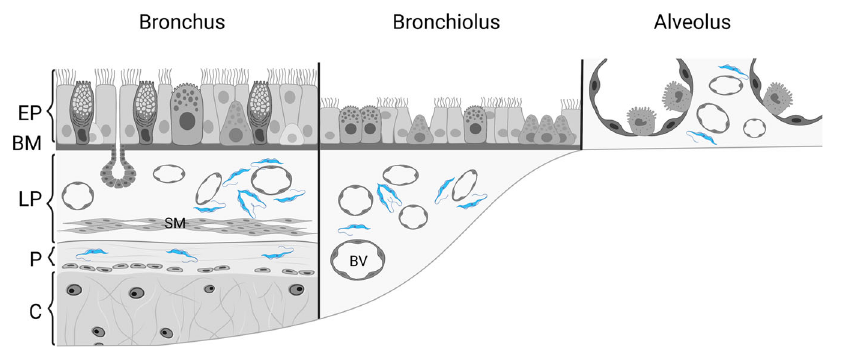
Fig.10|Parasitelocationinthelung. Schematicrepresentationoftheanatomical structure of the human airway (bronchus, bronchiolus and alveolus) with the locations where African trypanosomes (blue) are expected to be found based on